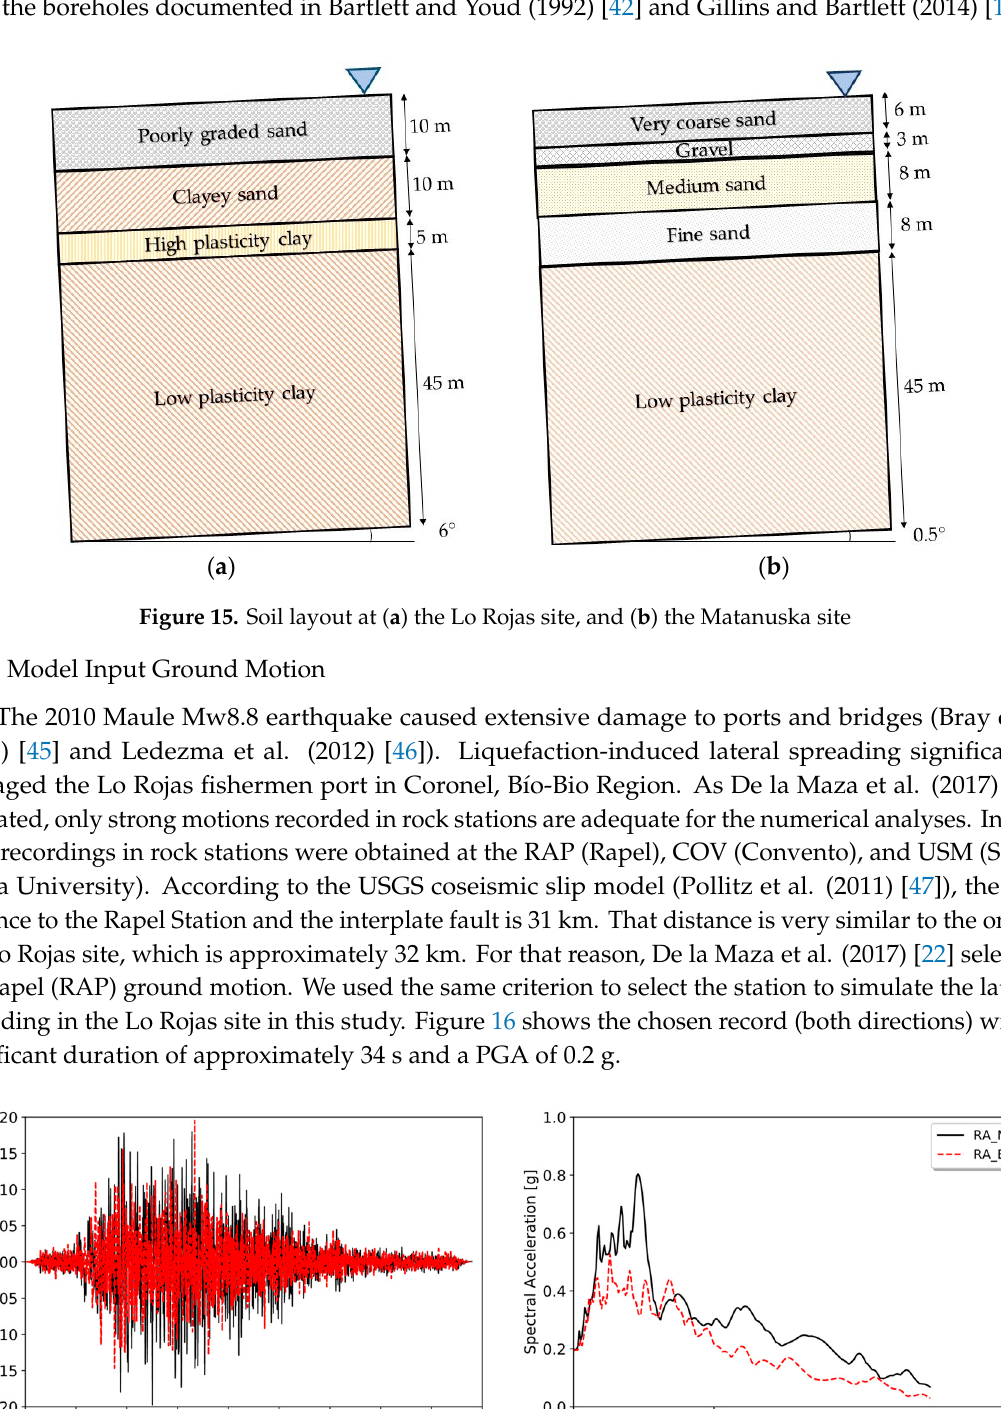
Figure 16. ( a ) North-South (NS) and East-West (EW) acceleration time histories for the Rapel station, ( b ) spectral acceleration (5% damping) of the NS and EW components for the Rapel station.